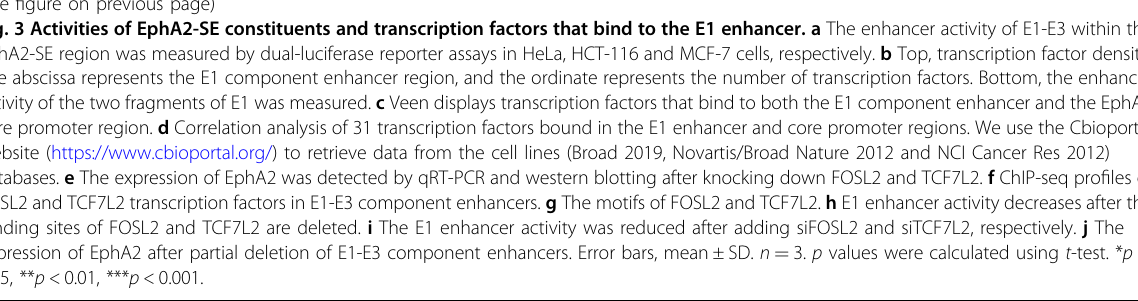
expression. The results showed that the expression of